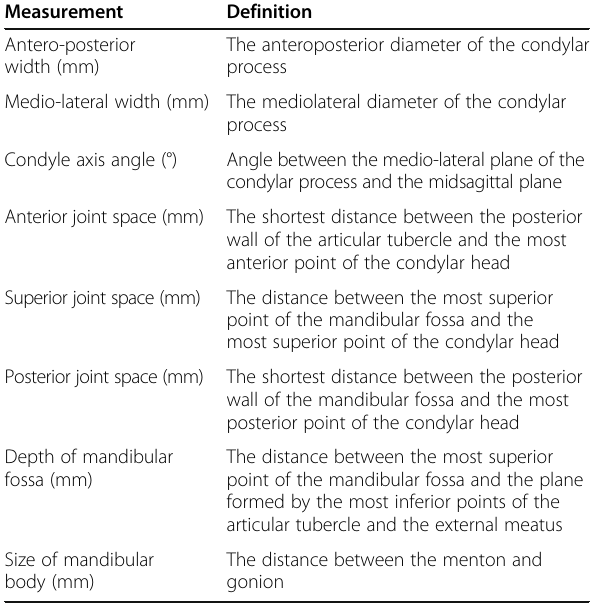
Table 1 The markers used in the analysis